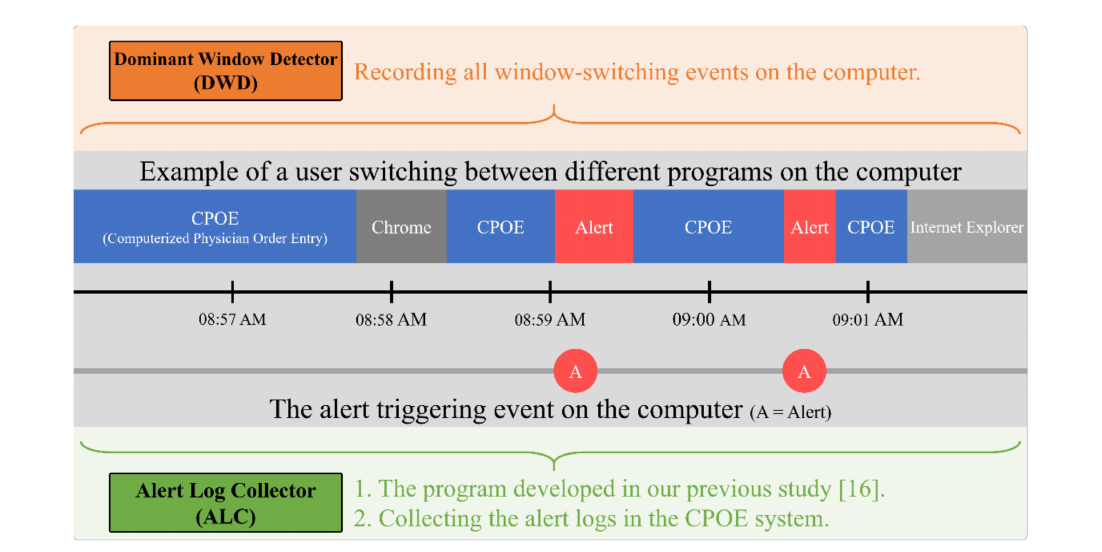
Figure 1. The process of DWD and ALC running on the computer. First, the data merging program checks for consistency in the computer’s IP address and dates between records of user-selected windows (collected by the dominant window detector) and alert log records (collected by the alert log collector) (Figure 2). If consistent, the time gap between the two records is calculated.